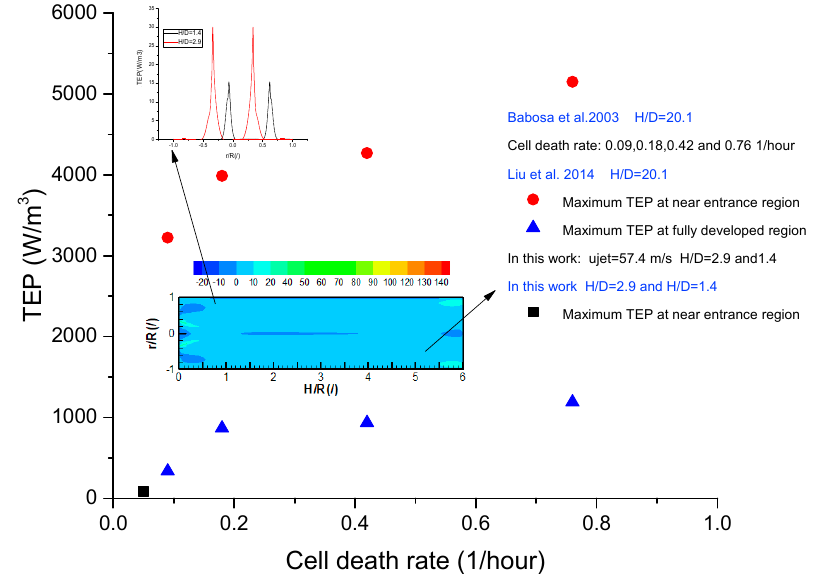
Figure 9. Distributions of two-phase turbulent energy production values near the inlet region and fully developed region using two jetting holes (rjet/R = ±0.36), H/D = 2.9 and H/D = 1.4.